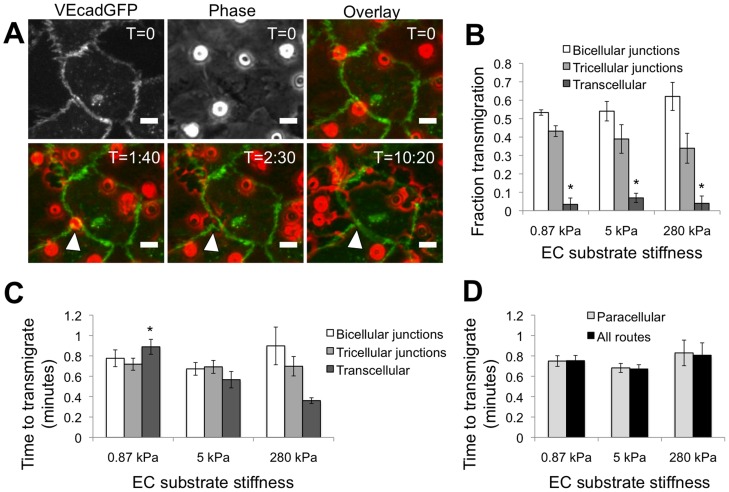
Location of transmigration.(A) Example of a neutrophil transmigrating at a tricellular junction of endothelial cells. The images were color-merged in ImageJ (VE-cadherin-GFP, green; phase contrast, red) to observe the location of transmigration in relation to endothelial cell borders. The white arrowhead points to the cell of interest that is transmigrating at the intersection of three endothelial cells. The time after plating neutrophils (in minutes∶seconds format) onto the endothelium is indicated in the top right corner of each image. Scale bar is 10 µm in all images. (B) Fraction of transmigrated cells (not total cells) that transmigrate via the bicellular junctions, tricellular junctions, or transcellular route, as a function of subendothelial matrix stiffness. Bars represent mean ± SEM of 3 independent experiments. * indicates P<0.05 with bicellular and tricellular junction routes on the same substrate stiffness by ANOVA, followed by Tukey's honestly significant difference criterion. There were no statistical differences between substrates for any route. (C) Time to complete transmigration as a function of route and subendothelial matrix stiffness. Bars represent mean ± SEM of pooled data from 3 independent experiments (on 0.87 kPa, N = 45, 37, 3 for bicellular, tricellular, and transcellular pathways, respectively; on 5 kPa, N = 28, 26, 5; on 280 kPa, N = 40, 21, 3). * indicates P<0.05 with 5 kPa and 280 kPa for the transcellular route by ANOVA, followed by Tukey's honestly significant difference criterion. (D) Time to complete transmigration is shown for all cells regardless of route taken, or cells taking the paracellular route (includes bicellular and tricellular junctions), as a function of subendothelial matrix stiffness. There were no statistical differences between any substrates or routes.